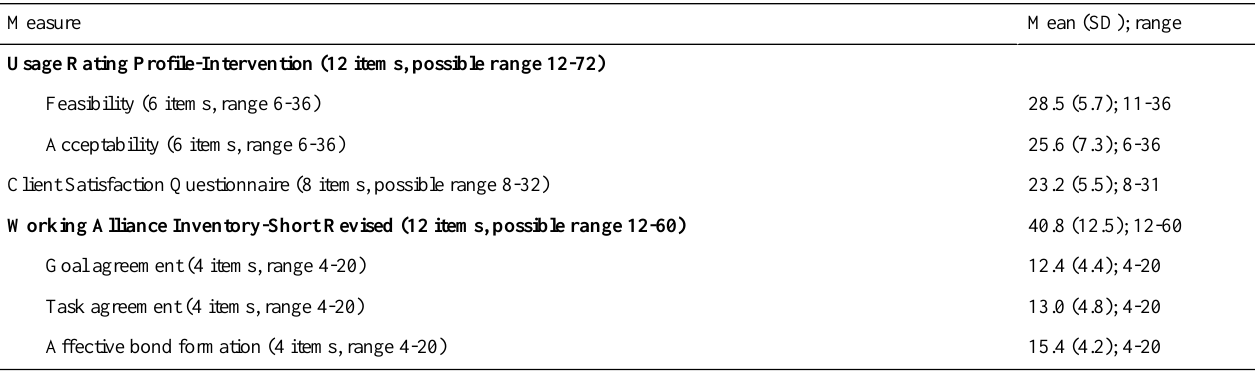
Mean (SD); rangeMeasure